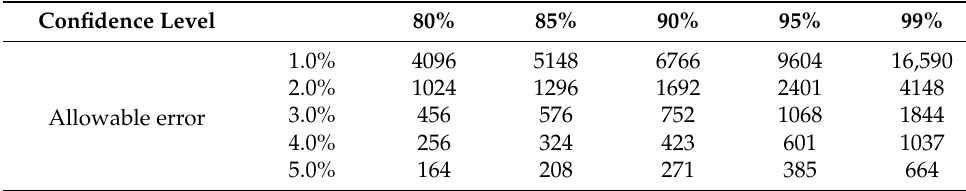
Table 2. The minimum sample size at the different error and confidence levels. Confidence